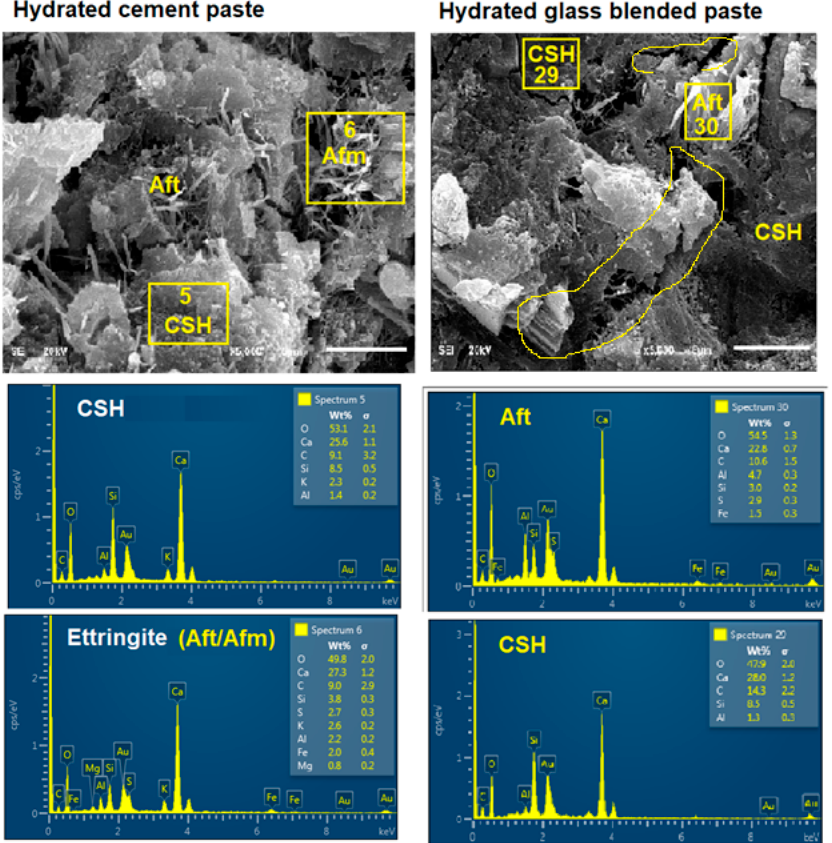
Figure 13. Microstructure of OPC and glass blended pastes (calcium-silicate-hydrate ((CSH) and Ettringite (Aft)).